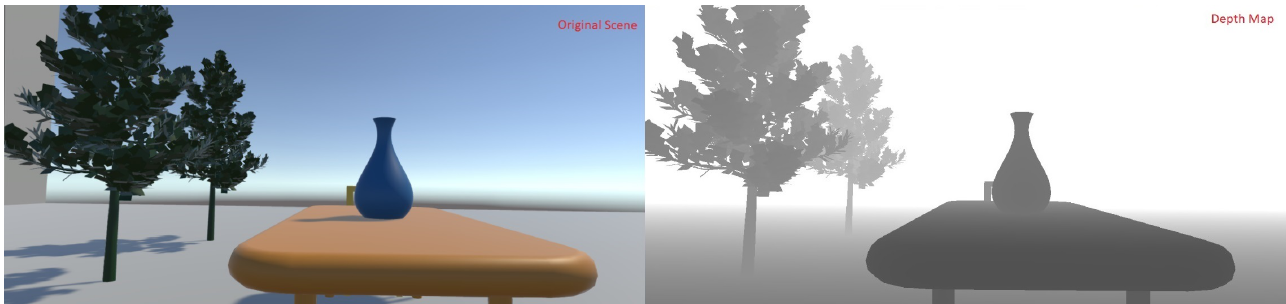
Figure 3. An example scene along with its associated depth map.